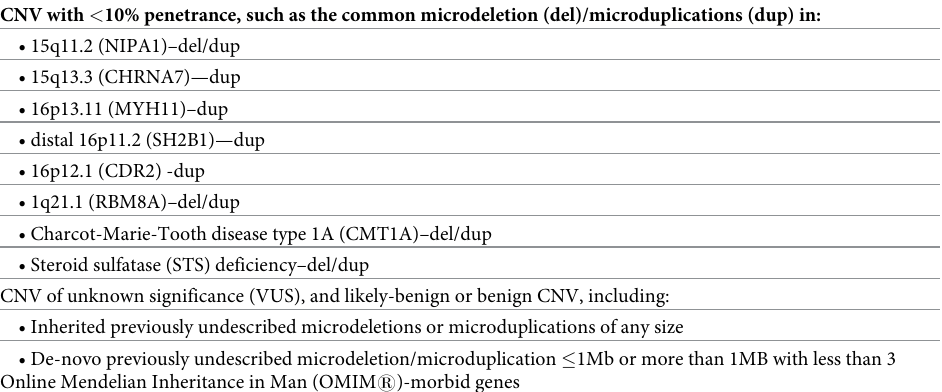
Table 1. CMA results not considered abnormal in the current study. CNV with < 10% penetrance, such as the common microdeletion (del)/microduplications (dup)